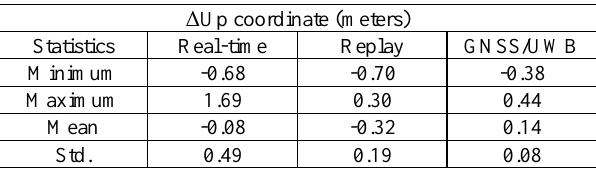
Table 7. Statistical value describing positioning errors in Up direction.